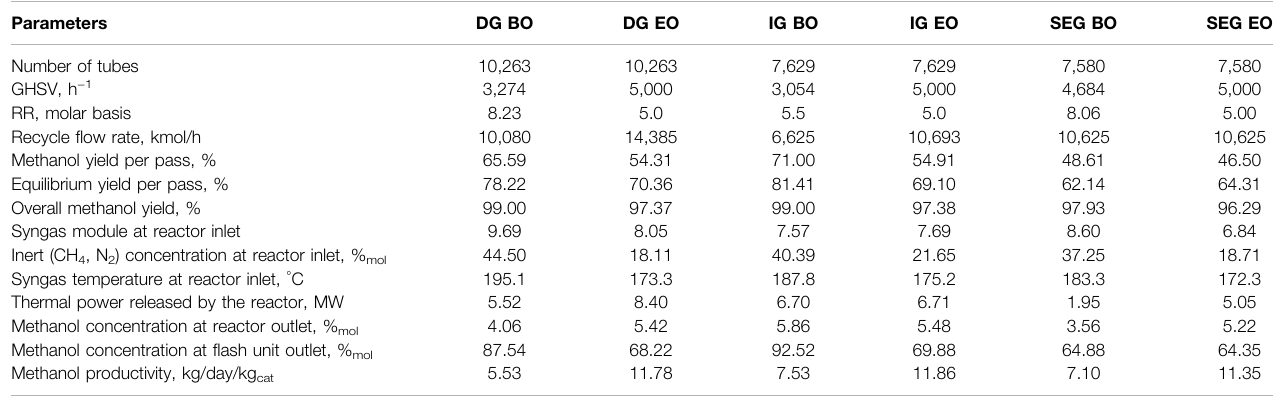
TABLE 4 | Performance of methanol synthesis. Parameters